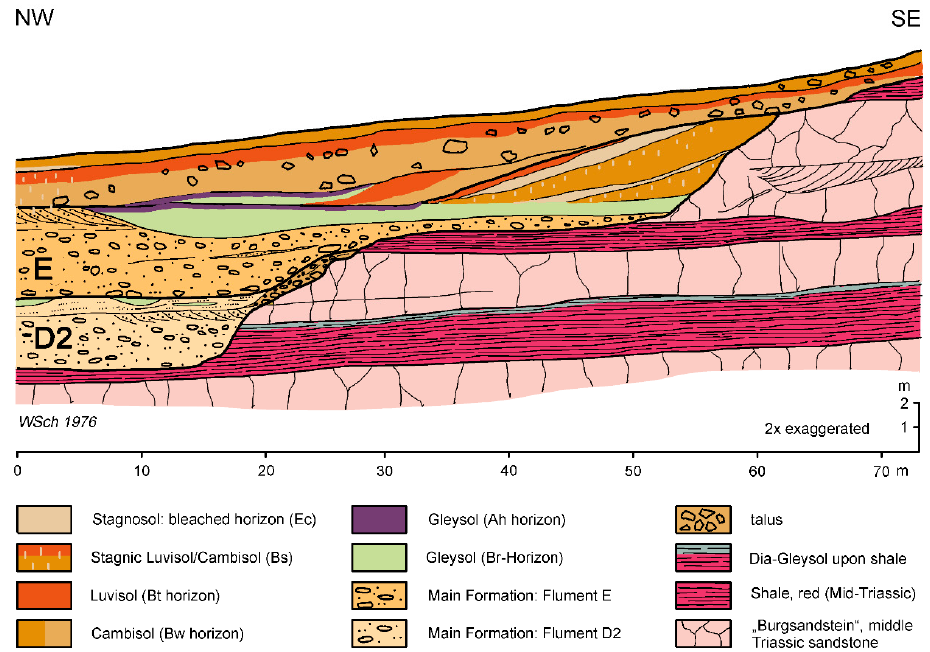
Figure 11. Flument overlap in the Main Formation. Flument D2 overlaps laterally more than 18 meters; Flument E overlaps 37 m.